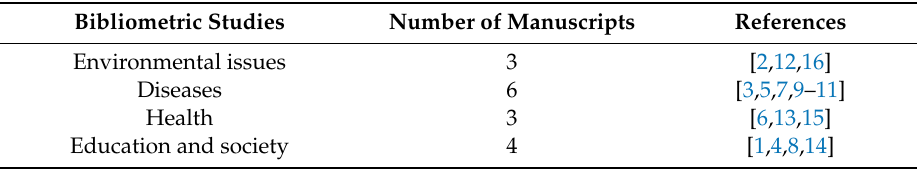
Table 3. Topics for worldwide research trends on global